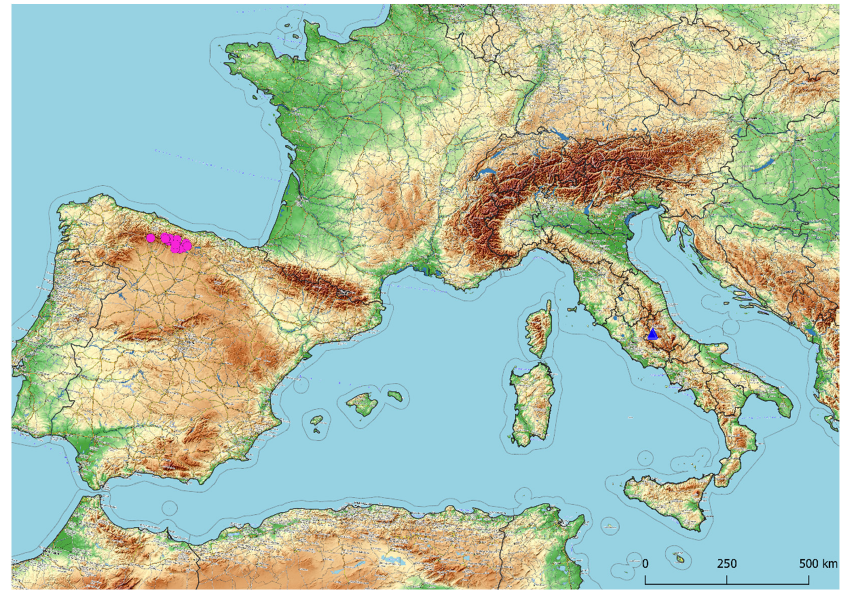
Figure 9. Distribution map of Allium ducissae (blue triangles), and A. palentinum (pink circles) according to the herbarium material examined. The map was used under a CC BY-SA copyright from OpenStreetMap contributors.